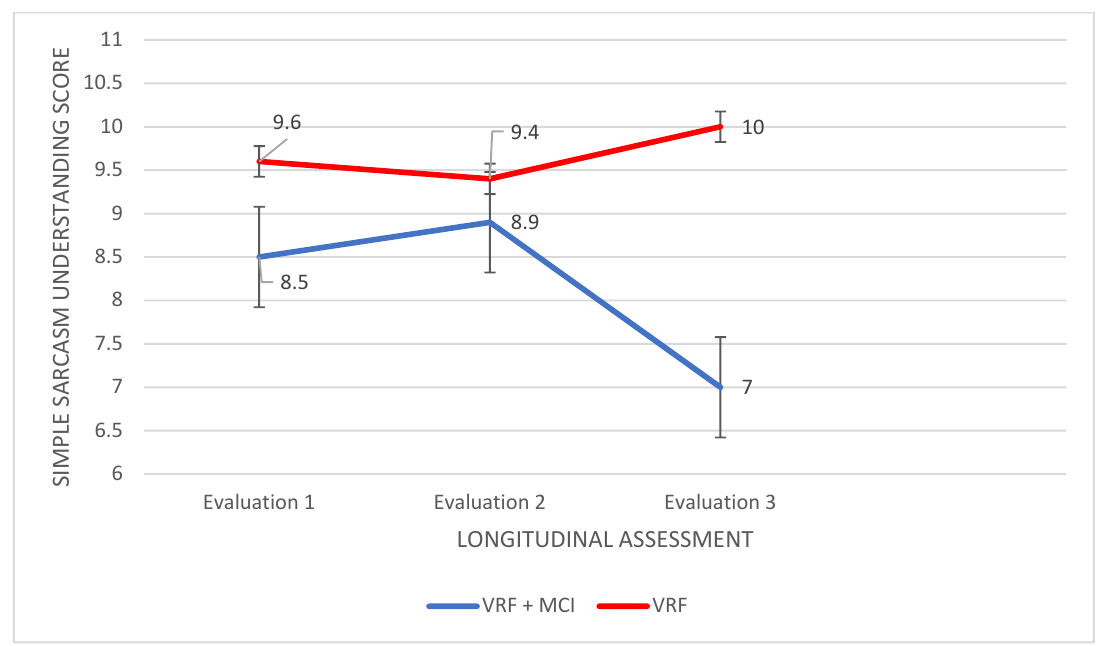
Figure 8. Performance of people with VRF and people with VRF + MCI in Simple Sarcasm under- standing (ToM abilities).